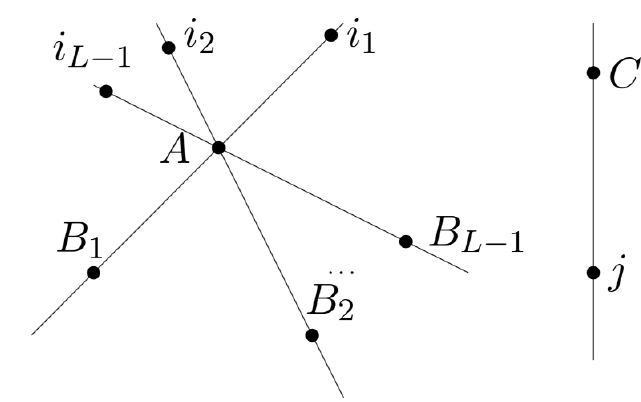
Figure 14 . Cut 1, where L (cid:0) 1 loops intersect in a common point A as well as L (cid:0) 1